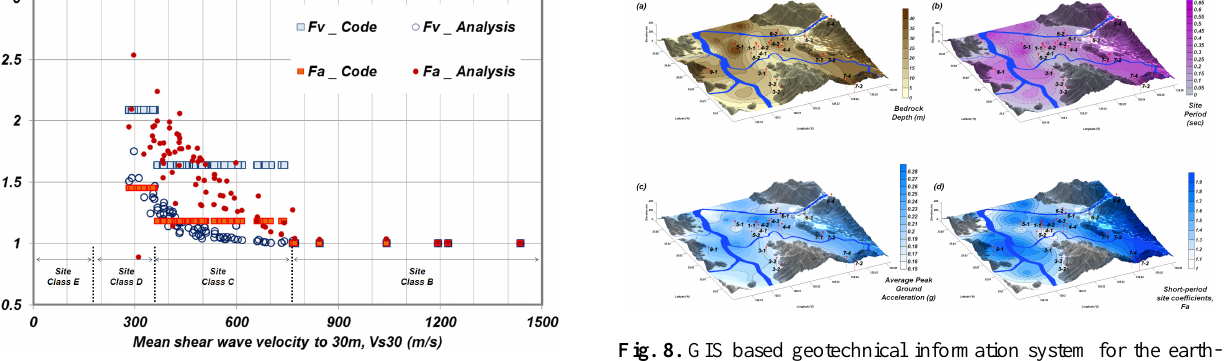
Fig. 6. Site amplification coefficients and corresponding site classi- fication based on the Vs30 for the earthquake level of 1000yr return period.